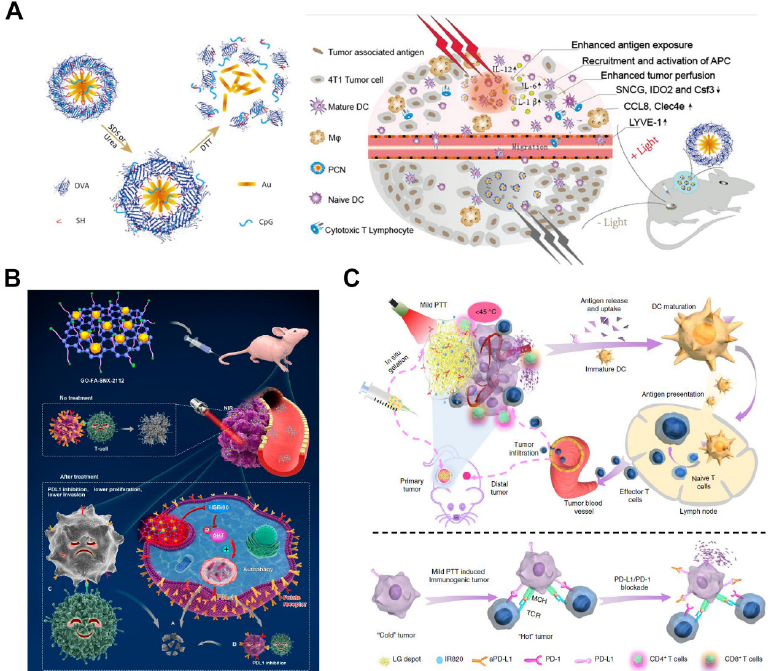
Figure 9. MTPTT assists in distinct types of immunotherapies. ( A ) The schematic of the disassembly process of PCN and an immunofavorable TME was established via a fever-like immune response induced by the photothermal effect of PCN [150]. Copyright © 2022, The Author(s). ( B ) Schematic structure of GO-FA-SNX-2112 and its application for MTPTT of the tumor to induce overactivation of autophagy; stimulated autophagy not only causes tumor cells to die directly but also makes them be captured by immunity because of the decrease in PDL1 receptor expression; residual surviving tumor cells are also gradually killed by restored immune cells, to achieve efficient inhibition of tu- mor growth [32]. Copyright © 2022, American Chemical Society. ( C ) Schematic illustration of the symbiotic mild photothermal-assisted immunotherapy via a combined all-in-one and all-in-control strategy [159]. Copyright © 2022, The Author(s).